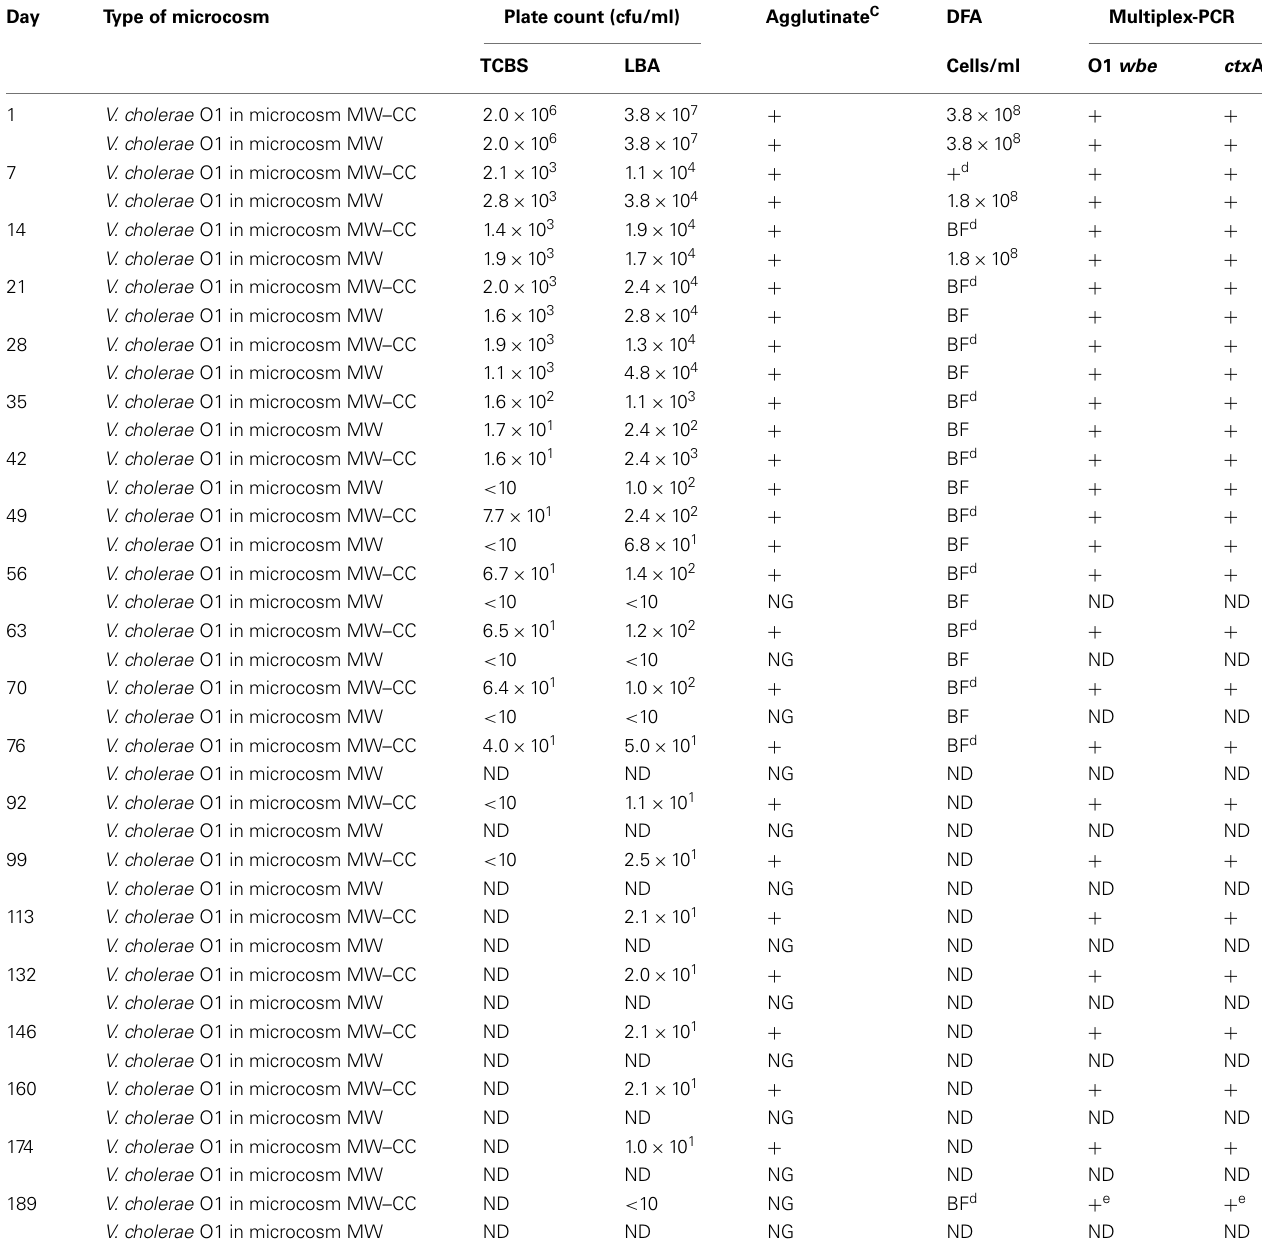
Table 1 | Comparison of V. cholerae O1 counts in Mathbaria pond water (MW) microcosms with and without chitin a,b .